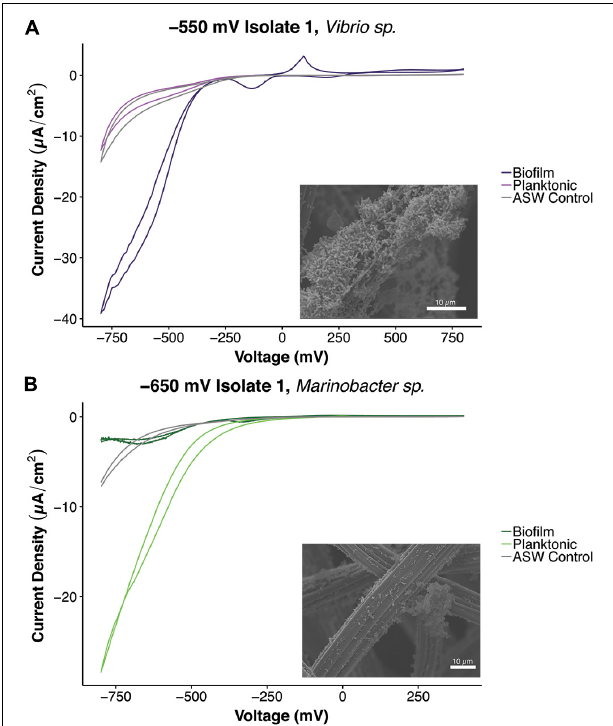
FIGURE 6 | Plots of cyclic voltammetry tests conducted under non-turnover conditions of different cell fractions and scanning electron microscopic characterization of biofilms of isolates, (A) –550 mV Isolate 1, Vibrio sp. and (B) –650 mV Isolate 1, Marinobacter sp. Separate cyclic voltammetry curves were obtained for planktonic and biofilm fractions. The Vibrio strain exhibited electrochemical activity in the biofilm state, and the Marinobacter strain demonstrated electrochemical activity in both the planktonic and biofilm fractions. CV curves shown were the average curves obtained after running three cycles (curves) for all tests.